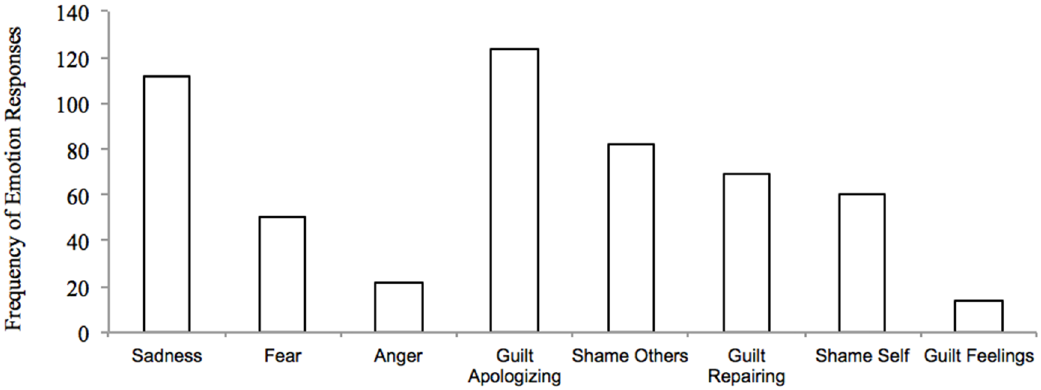
Figure 1. Frequency of emotion